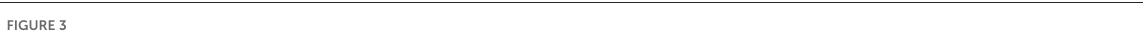
FIGURE3 A. tumefaciens strains carrying a binary vector encoding mCherry-HDEL and either 2xFP or 3xNeonGreen (NG) together with a strains expressing either 35S: 1 spAVR2/ 35S: 1 spSIX5 or 35S:GUS into N . benthamiana leaves. Green and red fluorescence was analyzed 72h after infiltration using confocal microscopy. Transformed cells show both a red ER-localized signal and a green nucleo-cytoplasmic-localized 2xFP or 3xFP signal (indicated by arrowheads) Scale bar represents 50 µ m. (D,E) Approximately 20–25 individual images based on two independent biological replicates were analyzed to quantify the cell-to-cell movement of 2xFP and 3xFP, respectively. Each data point represents a single image of a transformation border where the number of cell-to-cell movement events (i.e., number of cells) was scored ( **** = p < 0.0001, Mann–Whitney test). Error bars represent the standard error of the